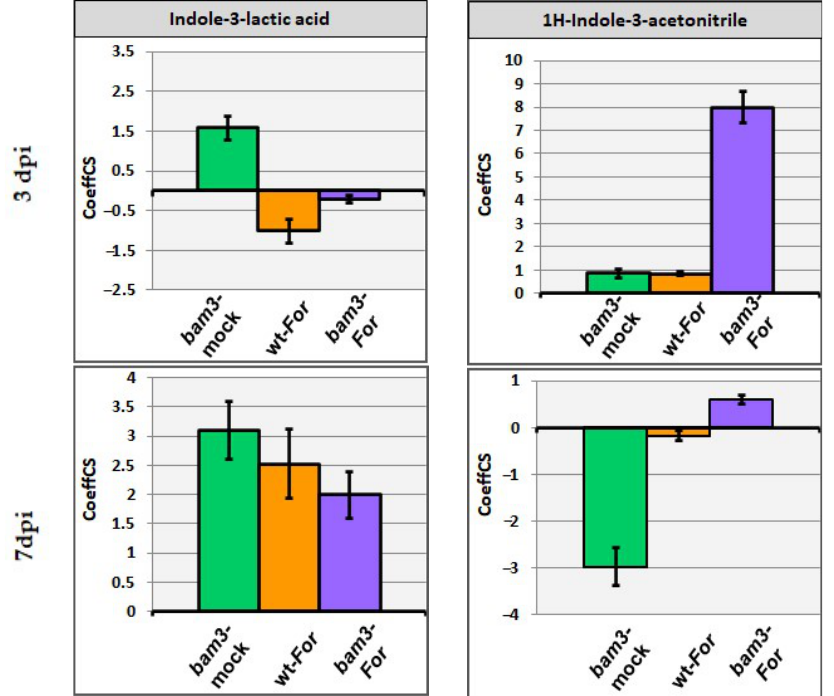
Figure 7. Centered partial-least squares (PLS) regression coefficients (CoeffCS) for the selected me- tabolites belonging to alkaloids: indole-3-lactic acid and 1H-indole-3-acetonitrile. CoeffCS repre- sents the relative differences in metabolite concentrations among mock bam3 plants, For -inoculated wt plants, and For -inoculated bam3 plants compared to wt mock plants (x axis) at three and seven dpi, displayed with Jack-knifed confidence intervals ( p < 0.05).